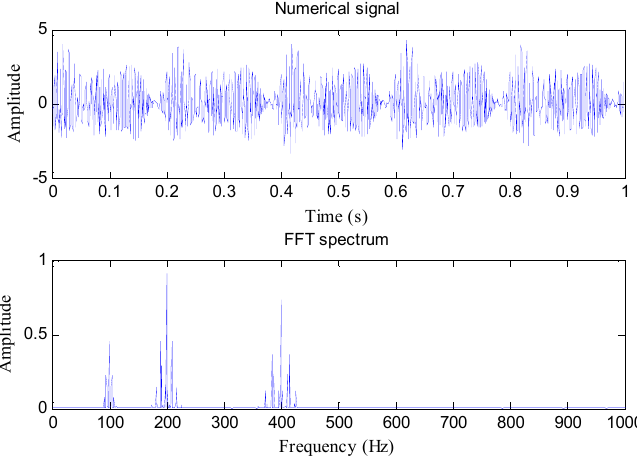
Figure 13. The numerical signal z ( t ) and its FFT spectrum.